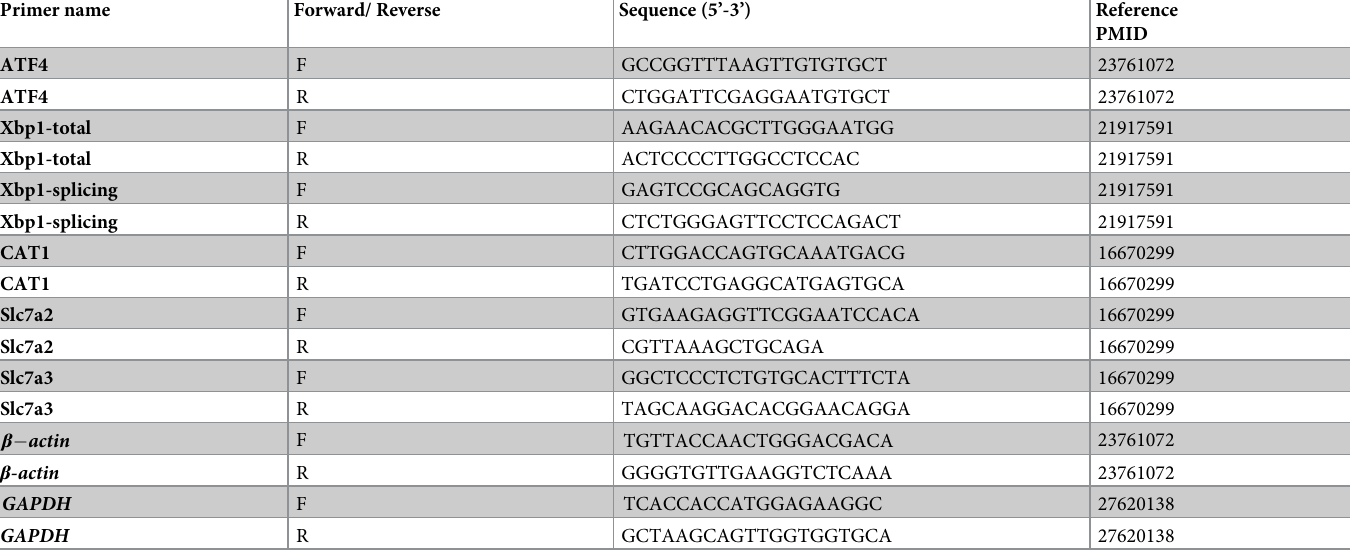
Table 1. List of primers used in this